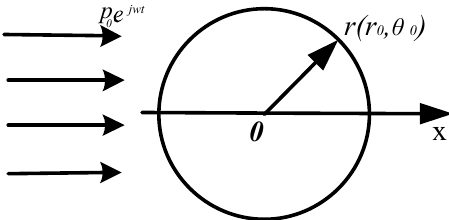
Figure 4. 2-D axial symmetry schematic diagram of the spherical OBS in free field.